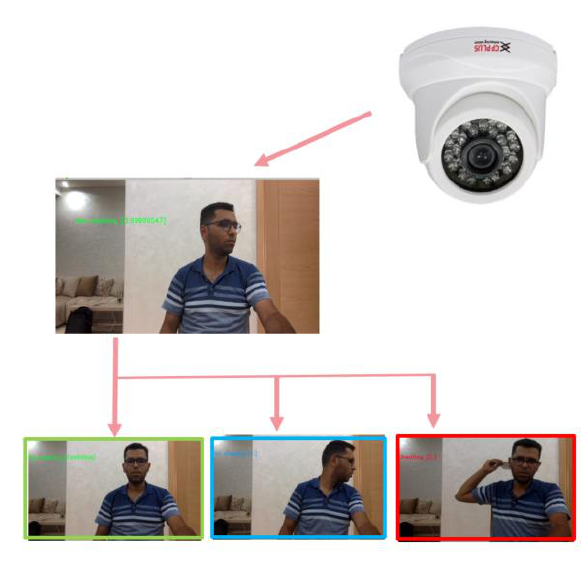
Figure 8. Real-time detection of scholar exams